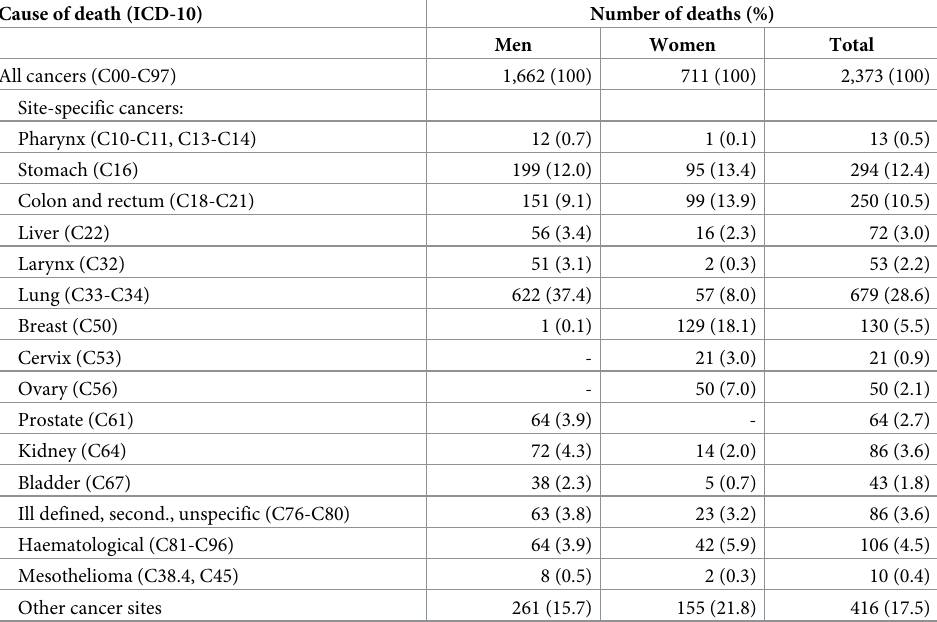
Table 3. Cancer deaths in the Asbest Chrysotile Cohort study,